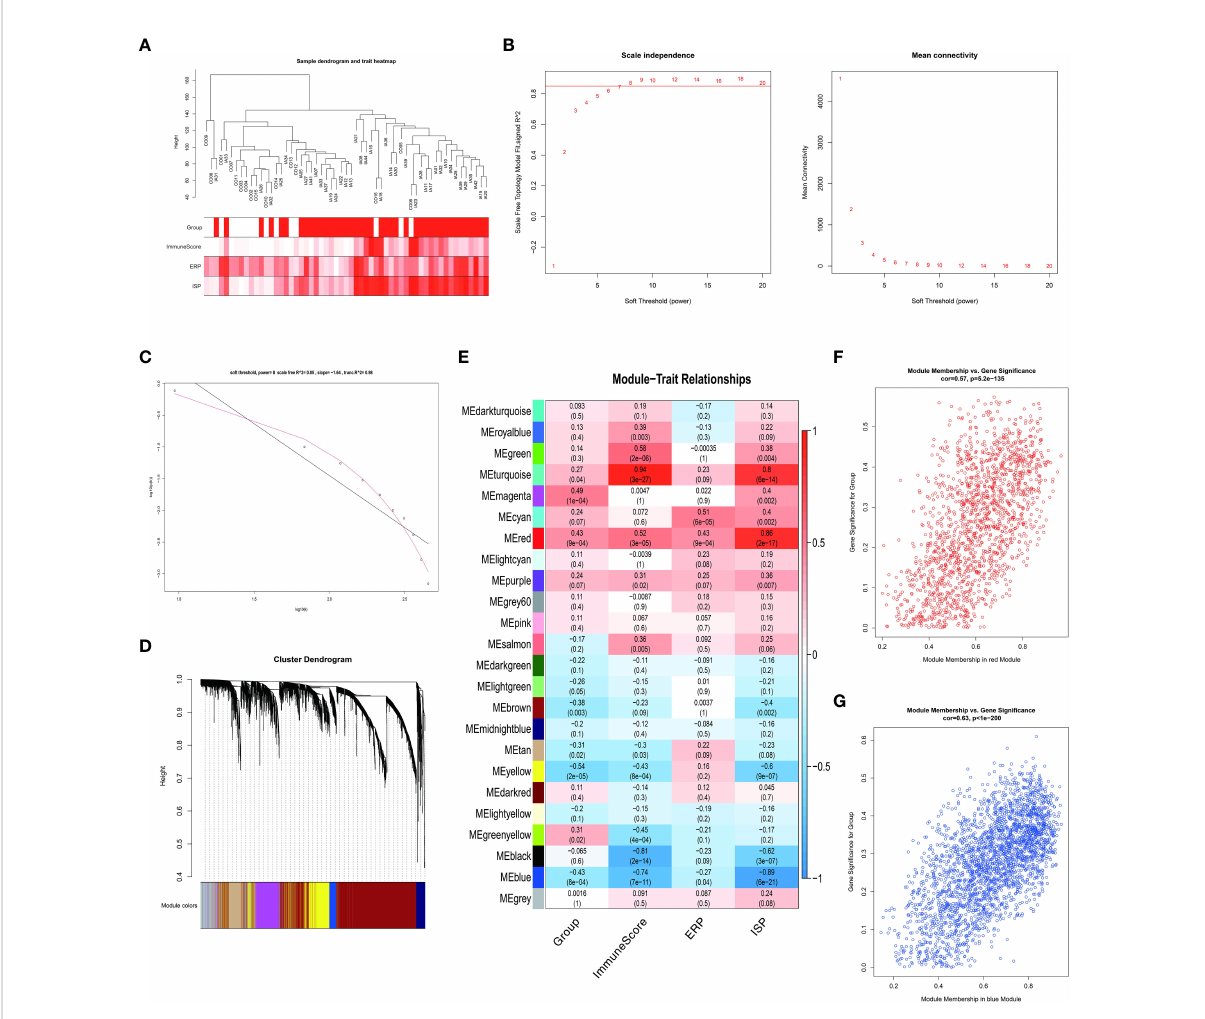
FIGURE 5 Weighted gene co-expression network analysis (A) Clustering dendrogram of total genes related to intracranial aneurysm (IA) onset. (B, C) Softthreshold power analysis implemented to obtain the scale-free fi t index of the network topology. (D) Identi fi cation of modules. (E) Heatmap shows the relationships between different modules and traits. (F) Scatter plot of module eigengenes in the red module. (G) Scatter plot of module eigengenes in the blue